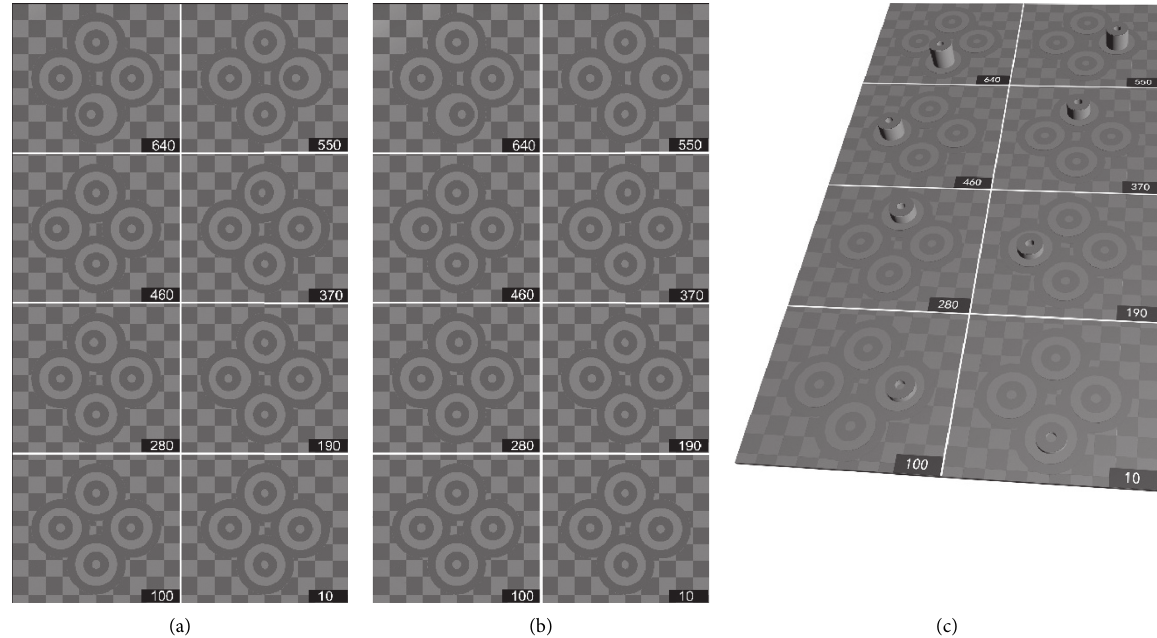
Figure 2: Legend of contour-based pattern of the first-grade test page with 30% contrast for a maximum brightness of 60 lux. (a) Picture viewed by the left eye. (b) Picture viewed by the right eye. (c) Simulation of the perception generated by the test images. The luminance of the dark and light elements was 32 lux (grayscale no. 39, RGB [99, 99, 99]) and 60 lux (grayscale no. 52, RGB [133, 133, 133]), respectively. The setting disparity of the stereo ring was 640 ″ (down), 550 ″ (right), 460 ″ (left), 370 ″ (up), 280 ″ (up), 190 ″ (left), 100 ″ (right), and 10 ″ (down). If the stereopsis of a subject is better than the setting disparity, the stereo target may appear out of the plane when fusing correctly.